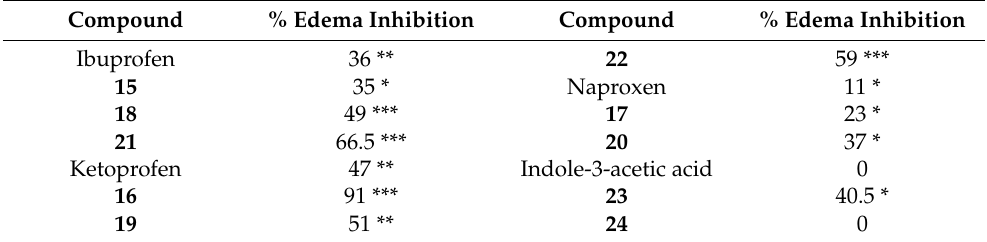
Table 1. Effect of the synthesized compounds and their parent acids on carrageenan-induced rat paw edema. The effect on edema is expressed as percent inhibition of edema in comparison to controls, which received carrageenan only. All compounds were administered i.p. (0.15 mmol/kg). Each value represents the mean obtained from five female rats (160–180 g b.w.), and standard deviation is always within 10% of the mean value. Compound % Edema Inhibition Compound % Edema Inhibition Ibuprofen 36 ** 22 59 *** 15 35 * Naproxen 11 * 18 49 *** 17 23 * 21 66.5 *** 20 37 * 47 ** 0 23 40.5 *